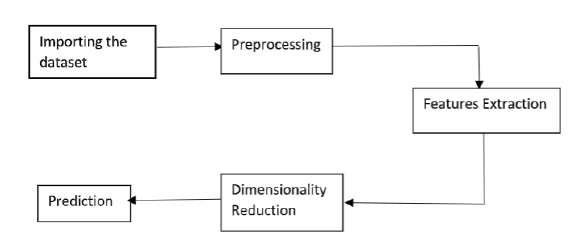
Figure 1. Proposed Methodology